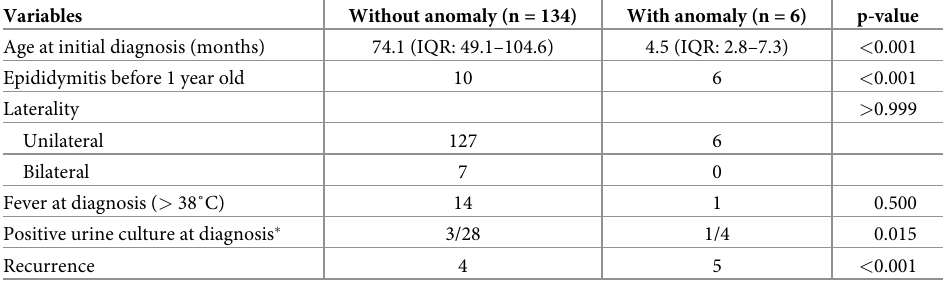
Table 4. Comparison of clinical parameters between AE patients with and without genitourinary anomalies in the unknown genitourinary anomaly status group (N =